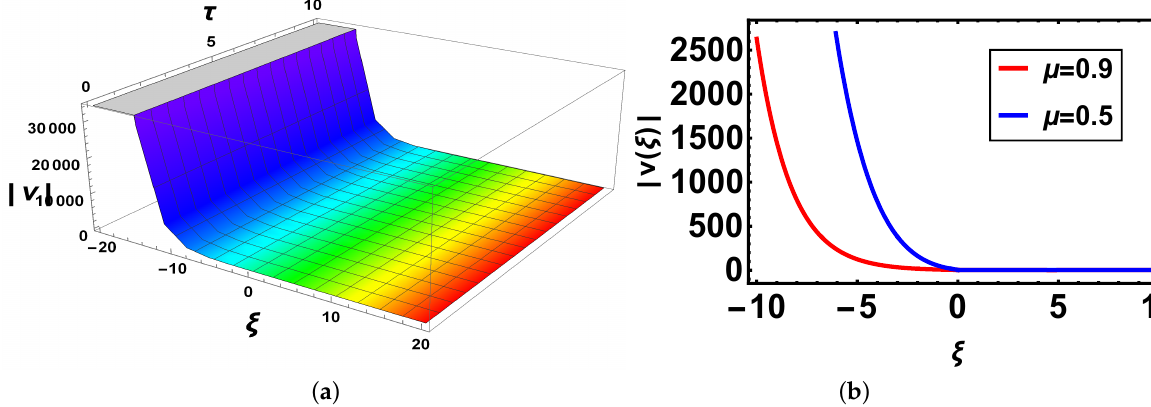
Figure 4. ( a ) 3D and ( b ) 2D plots with same parameter values as above µ = 0.9 and Θ = 1.1 of v 1 ( ξ , τ ) with the M-truncated derivative.